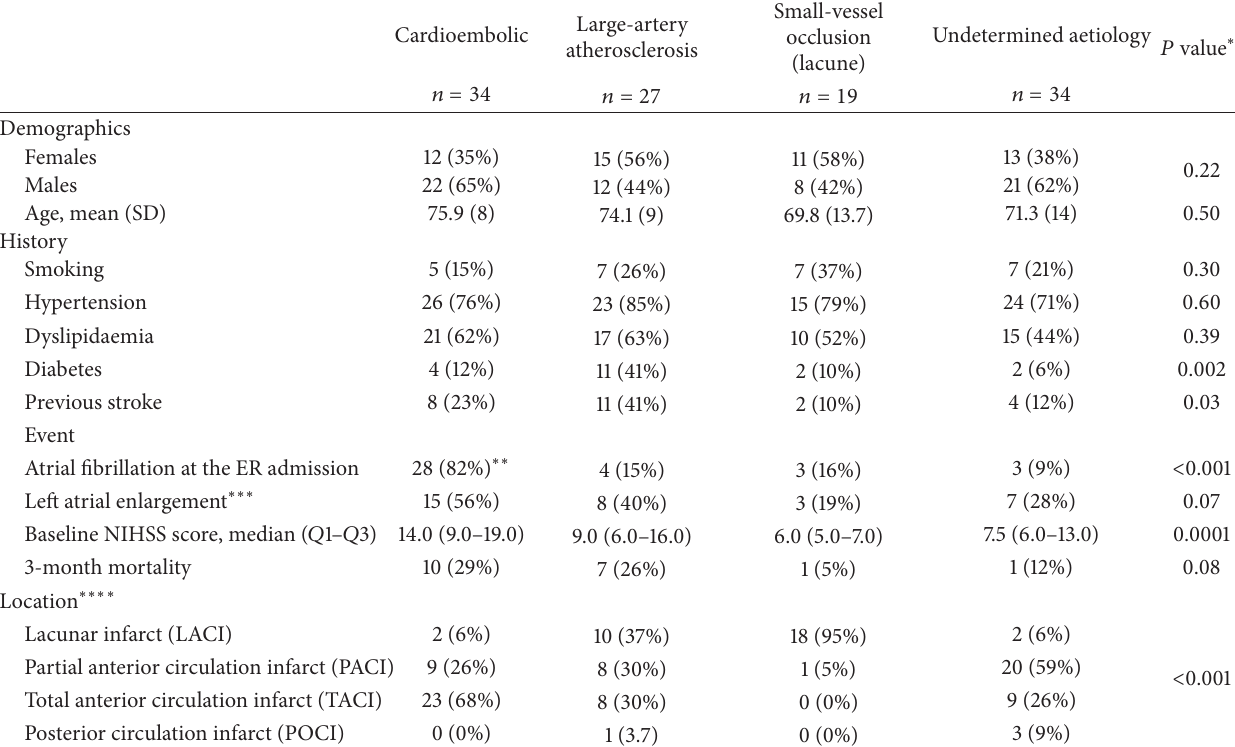
Table 1: Demographic and clinical features in 114 patients with stroke according to TOAST classification.